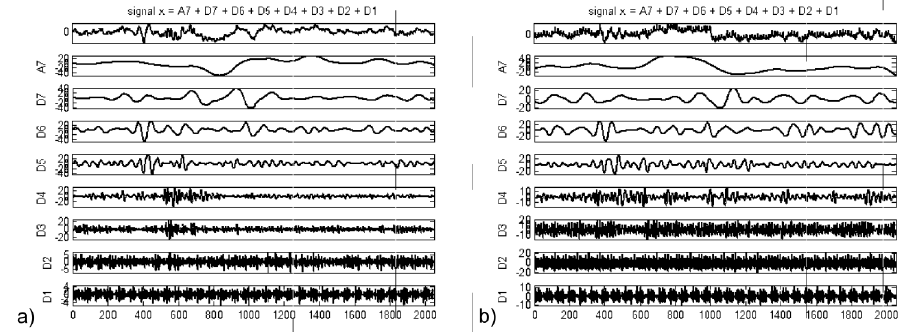
Figure 1. Multiresolution analysis of EEG signal between epileptic discharges: D1-D7 details, A7 – approximation from channels a) F7-T7, b)